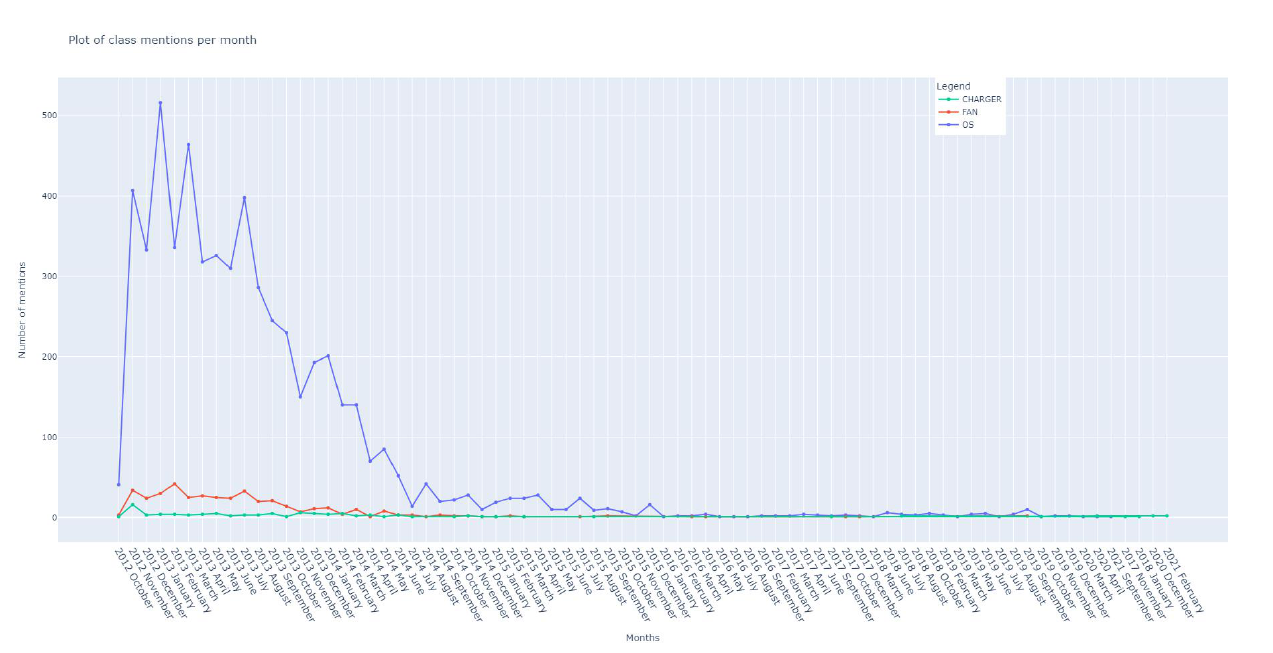
Figure 12. Product aspect class ranking for positive opinions.